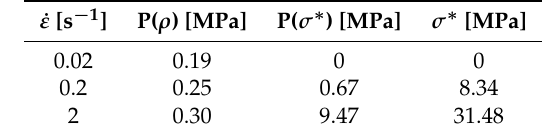
Table 3. Comparison between the driving pressure contributions from dislocation density and dynamic stress.